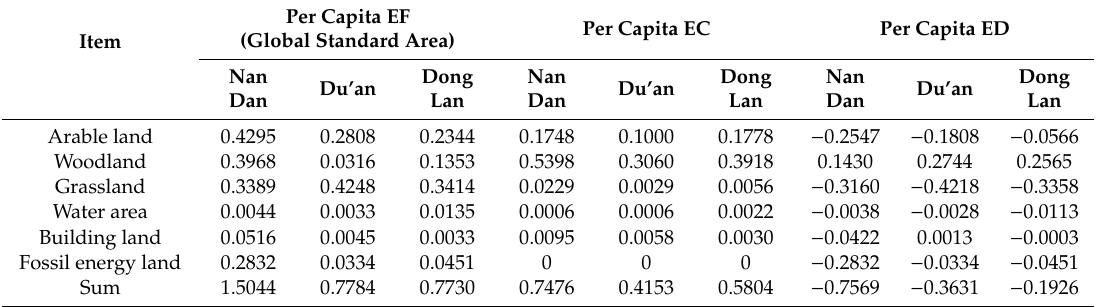
Table 7. Summary of the per capita EF, EC, and ED of Nandan, Du’an, and Donglan Counties